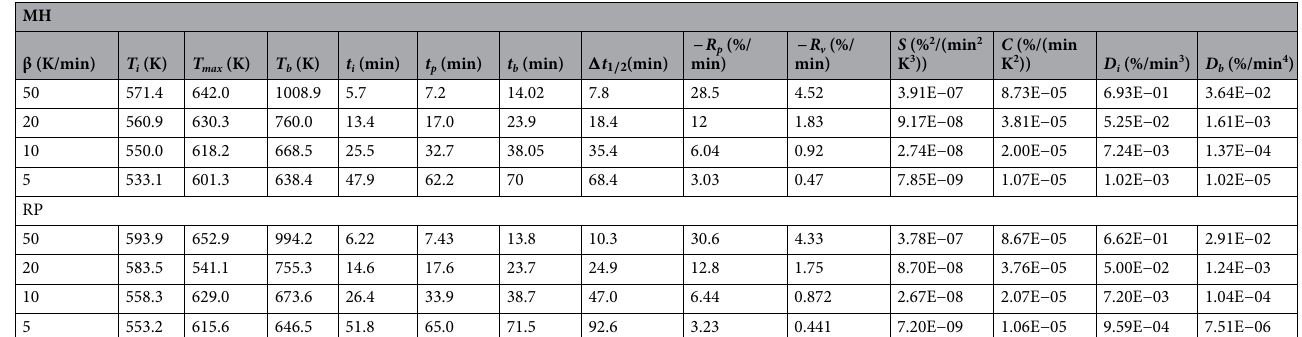
Table 3. Pyrolytic thermal performance of MH and RP at different heating rates.